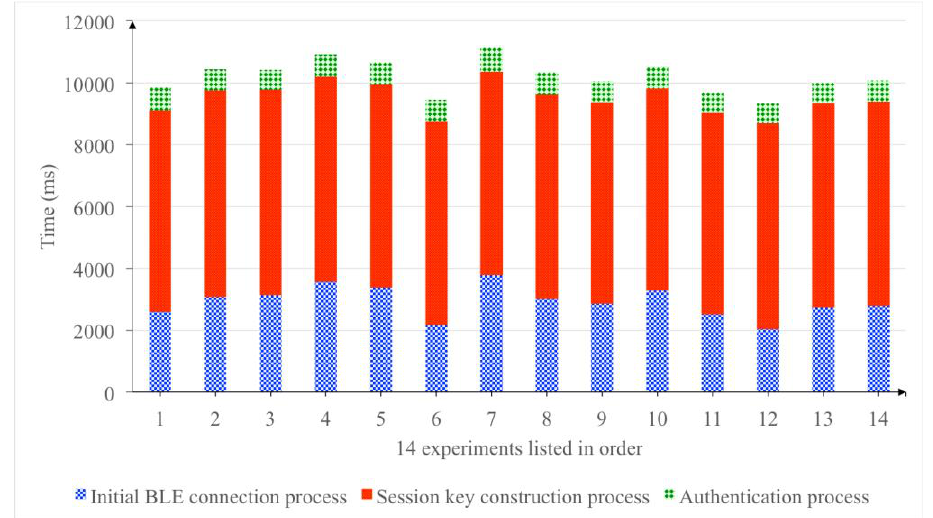
Figure 14. The time consumption of the prototype to establish one payment session in 14 different experiments.